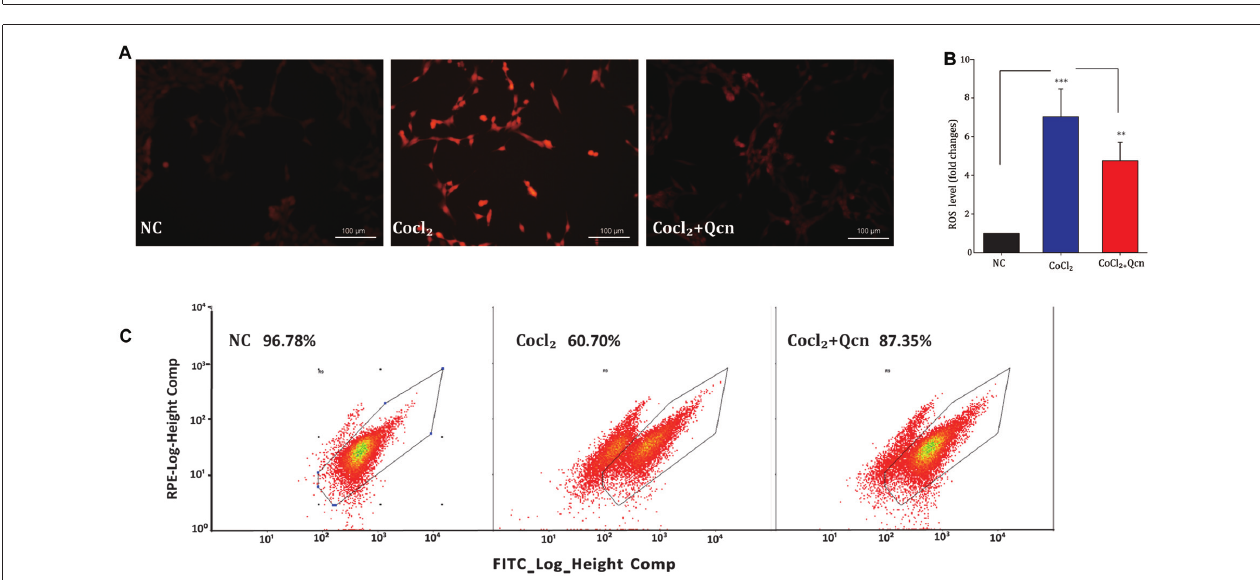
FIGURE 9 | (A) Reactive oxygen species (ROS)-induced fluorescence was visualized by confocal microscopy. Scale bar, 100 µ m. (B) Quantitative analysis of ROS fluorescence intensities in RGCs from different treatment groups. The data are presented as the mean ± SD, ∗∗ p < 0.01 and ∗∗∗ p < 0.001. (C) Flow cytometry analysis of ROS generation shows a leftward-shift in the log of FITC in the CoCl 2 -treatment group, whereas Qcn treatment effectively alleviates the shift.